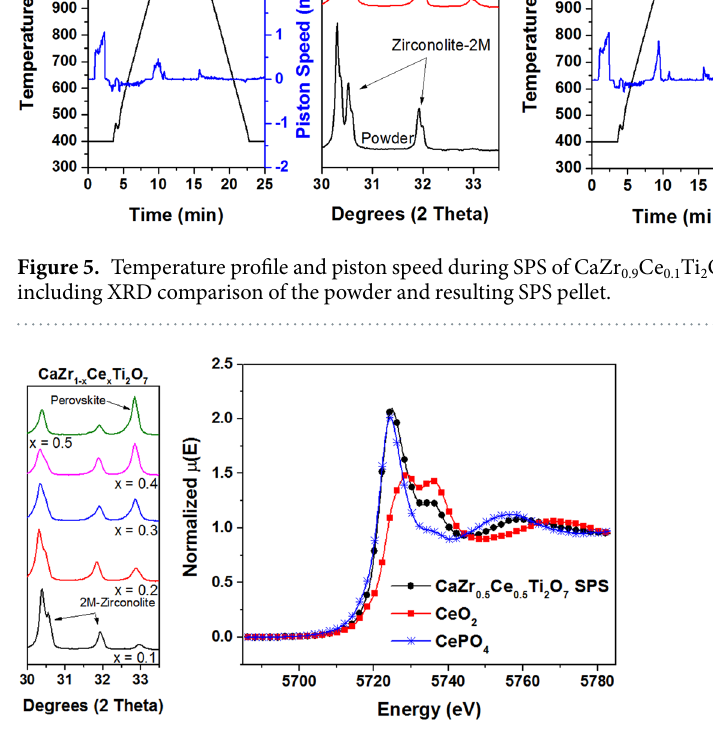
Figure 6. XRD comparison of SPS Ce-substituted zirconolites along with XANES results showing a majority of trivalent